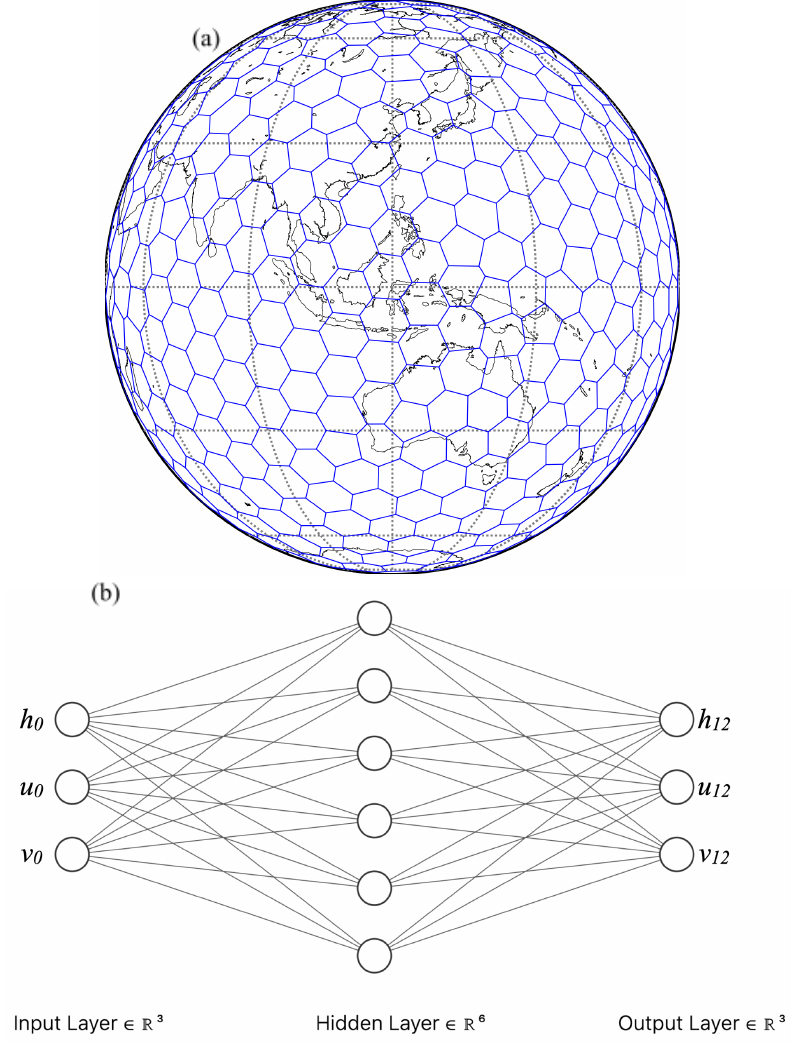
Figure 1. ( a ) Spatial distribution of the Spherical Centroidal Voronoi Tessellation (SCVT) mesh at 1000 km with 611 cells globally. ( b ) The neural network diagram showing the structure of the Fig. 1: (a) Spatial distribution of the SCVT mesh at 1000 km with 611 cells globally. (b) The NN-based MPAS-SW model. The actual number of the neurons for the input and output layers is neural network diagram showing the structure of the NN-based MPAS-SW model. The actual N = 1833, and N = 3666 for the hidden number of the neurons for the input and output layers is N=1833, and N=3666 for the hidden layer.